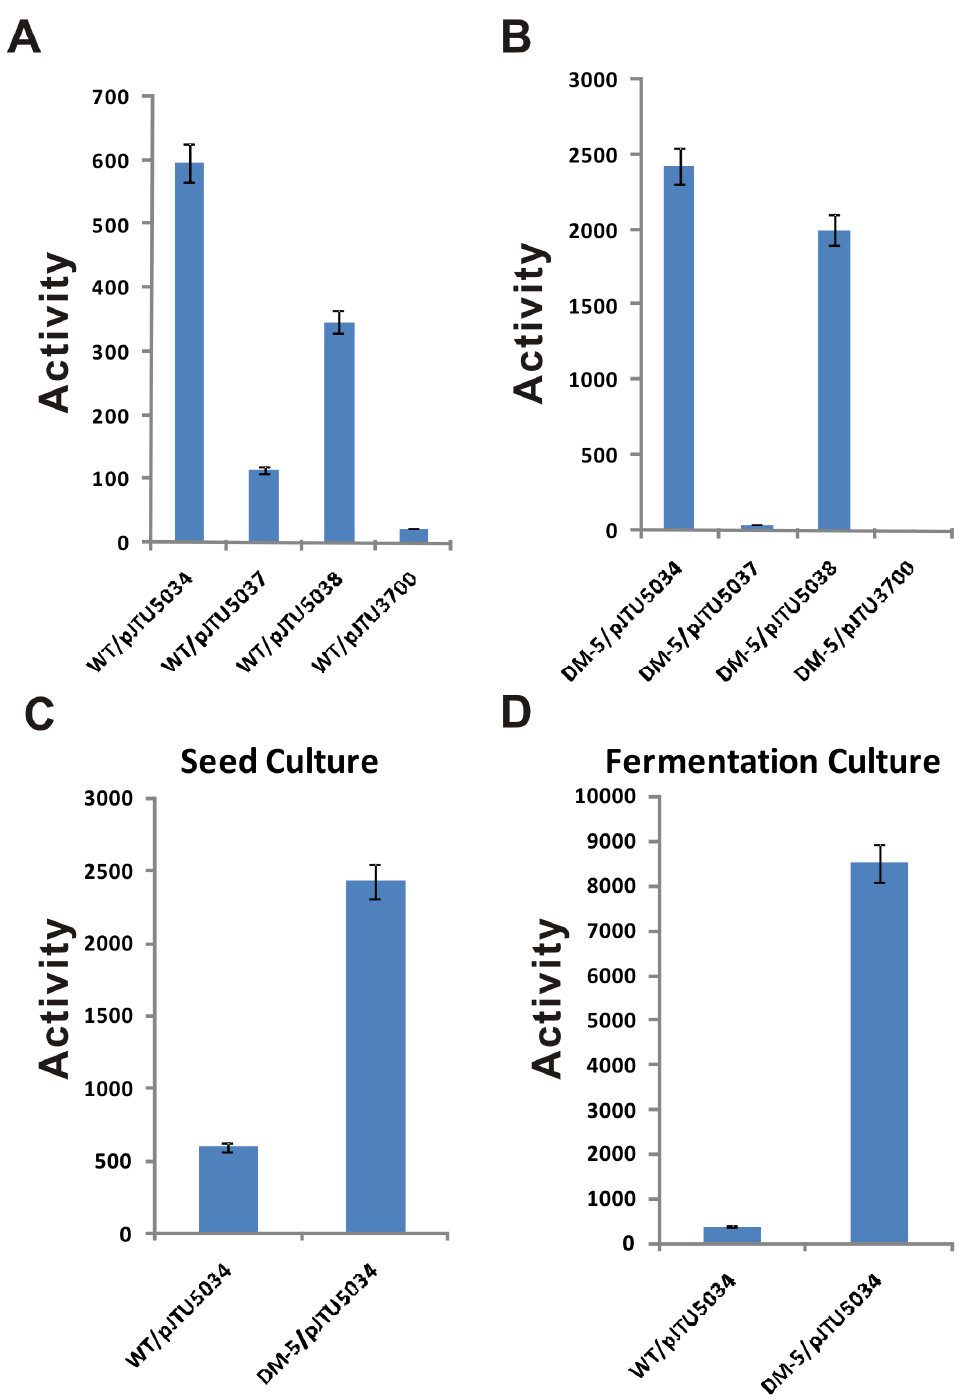
Figure 5. Analysis of mur33 promoter by catechol dioxygenase activity assay. (A) The enzyme activities for the seed cultures of WT/ pJTU5034, WT/pJTU5037 and WT/pJTU5038. (B) The enzyme activities for the seed cultures of DM-5/pJTU5034, DM-5/pJTU5037 and DM-5/pJTU5038. (C) The enzyme activities for the seed cultures of WT/pJTU5034 and DM-5/pJTU5034. (D) The enzyme activities for the fermentation cultures of WT/ pJTU5034 and DM-5/pJTU5034. All histograms showed the quantitative catechol dioxygenase activity of Streptomyces sp. NRRL30471 and DM-5 independently containing pJTU5034, pJTU5037, pJTU5038 and pJTU3700. WT/pJTU3700 indicates Streptomyces sp. NRRL 30471 containing pJTU3700 (no mur33 promoter) is as the negative control. WT/pJTU5034, indicates Streptomyces sp. NRRL 30471 containing pJTU5034 (natural mur33 promoter). WT/pJTU5037 indicates Streptomyces sp. NRRL 30471 containing pJTU5037 (the -10 region mutated on mur33 promoter). WT/pJTU5038 indicates Streptomyces sp. NRRL 30471 containing pJTU5038 (the -35 region mutated on mur33 promoter). Likewise, DM-5 derived strains were designated.